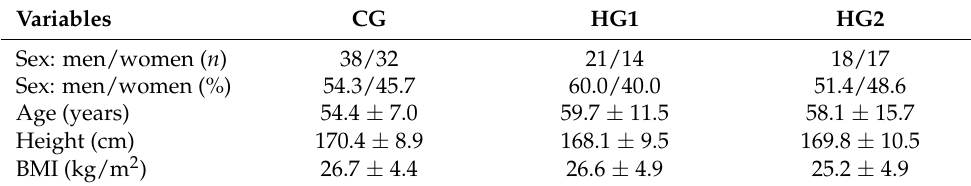
Table 1. General characteristics of the study participants (means ± SD or n , %).